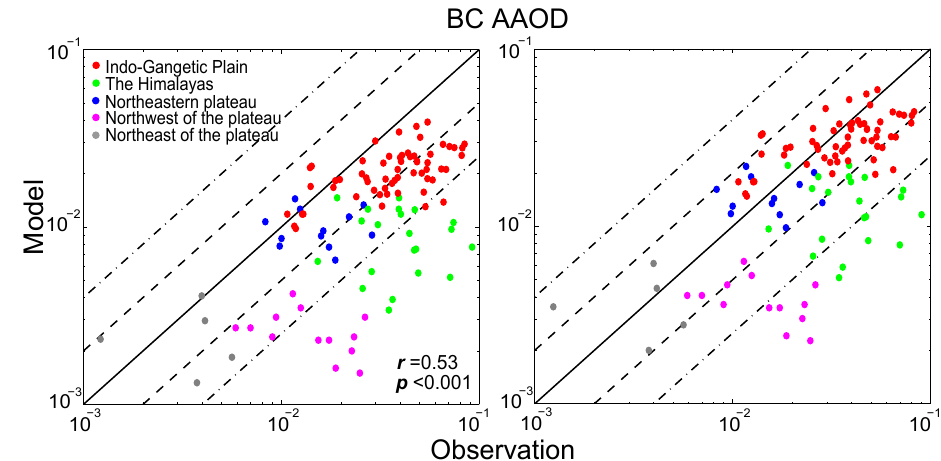
Figure 9. Observed and GEOS-Chem simulated monthly mean BC AAOD at AERONET sites over the Tibetan Plateau (see Table 3 and Fig. 1). Left panel: assuming external mixing of BC. Right panel: assuming a 50% increase of BC absorption associated with internal mixing. Regions are color-coded: Indo-Gangetic Plain (red), the Himalayas (green), the northeastern plateau (blue), northeast of the plateau (grey), northwest of the plateau (magenta). Solid line is a 1:1 ratio line; dashed lines are 1:2 (or 2:1) ratio lines; dashed-dotted lines are 1:4 (or 4:1) ratio lines. Also shown are the correlation coefficient ( r) and p value. Values are for 2006 unless stated otherwise. See text for details.